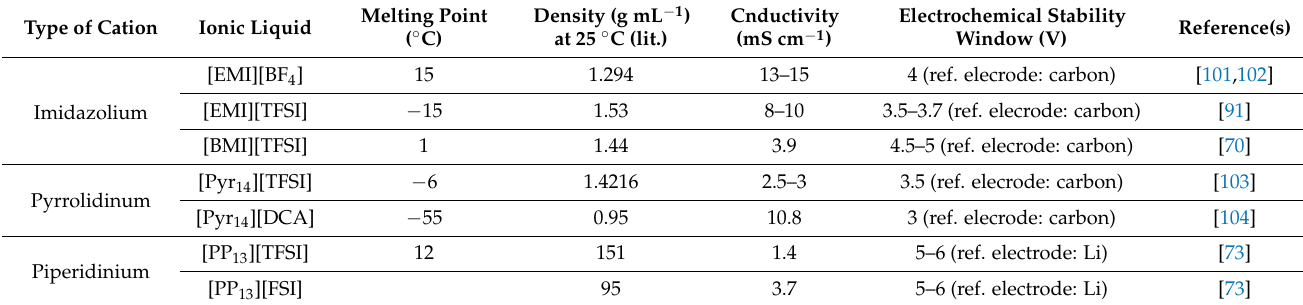
Table 2. The properties of representative